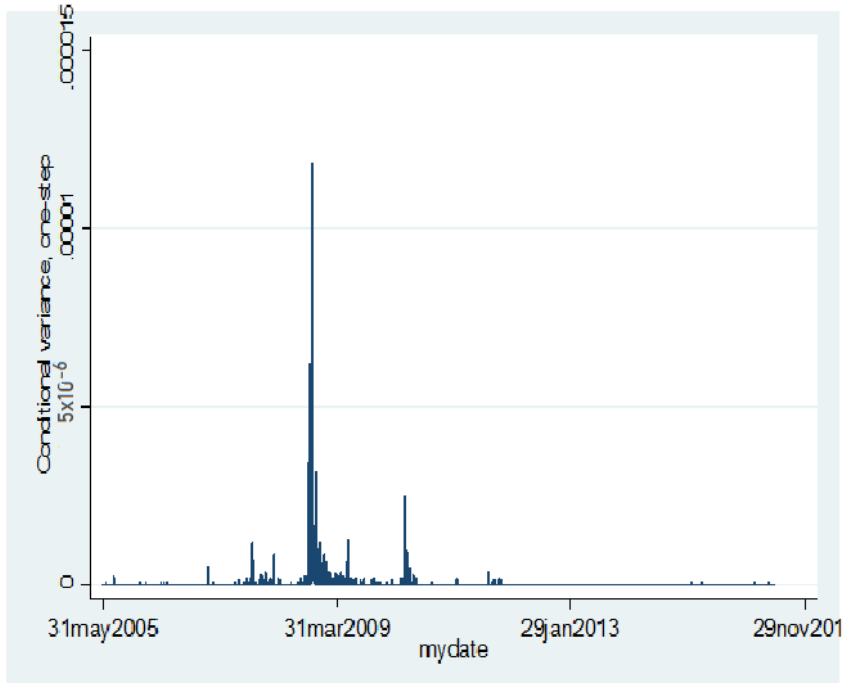
Figure 5. Results of the global foreign exchange market time-varying volatility, over the time period 2005–2016, using the ARCH (1) model. Note: This figure shows the persistence in time-varying volatility between developed and developing countries over the time period 2005–2016. The underlying currencies across developed and developing countries, including the most traded globally, are described in the data section.